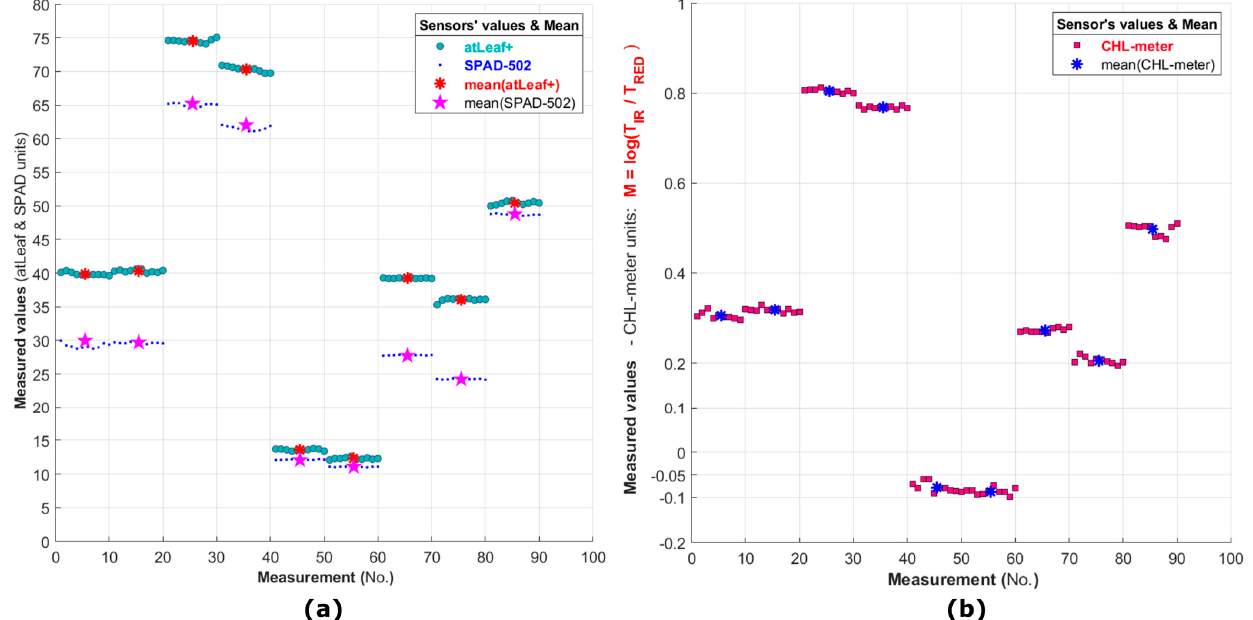
Figure 10. In Figures ( a , b ) the repetitive measurements on the 9 green-only color filters (numbered no. 1, 2, 3, 4, 7, 8, 9, 10, and 13 in Figure 7) are shown. In ( a ), the measurements with atLeaf and SPAD are plotted while in ( b ) the same measurements with the proposed device are shown. The numbers on the plot correspond to the filters presented in Section 2.3.2, Figure 7. The red and blue asterisks as well as the magenta star represent the mean of the 10 values plotted for each filter. Each value plotted is the mean of 5 measurements per point.